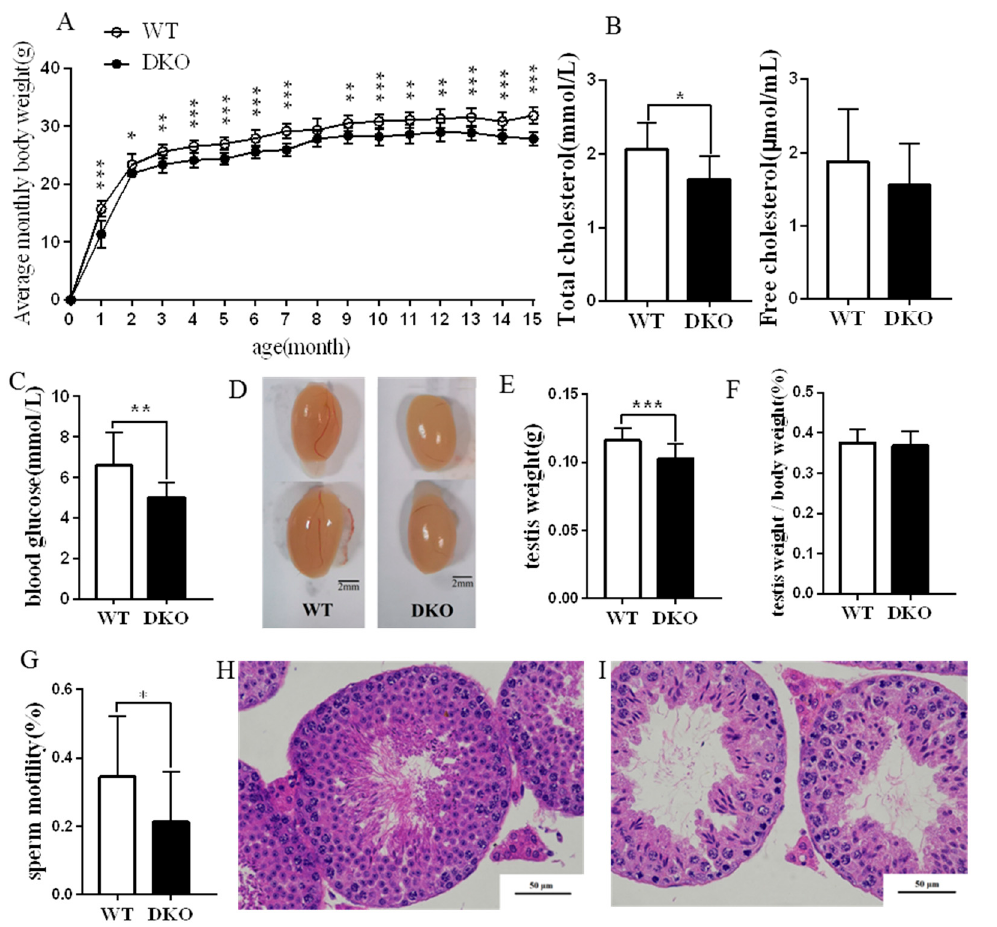
Figure 1. Physiological effect indices and HE staining results of 15-month-age DKO and WT mice. ( A ) Bodyweight growth curve; ( B ) Total cholesterol and free cholesterol; ( C ) Fasting blood glucose levels; ( D ) Testicular appearance (left side at the top, right side at the bottom); ( E ) Testicular weight; ( F ) Ratio of testis weight/body weight; ( G ) Sperm motility; ( H ) HE staining of WT testis; ( I ) HE staining of DKO testis ( n = 10; * p < 0.05; ** p < 0.01, *** p < 0.001).